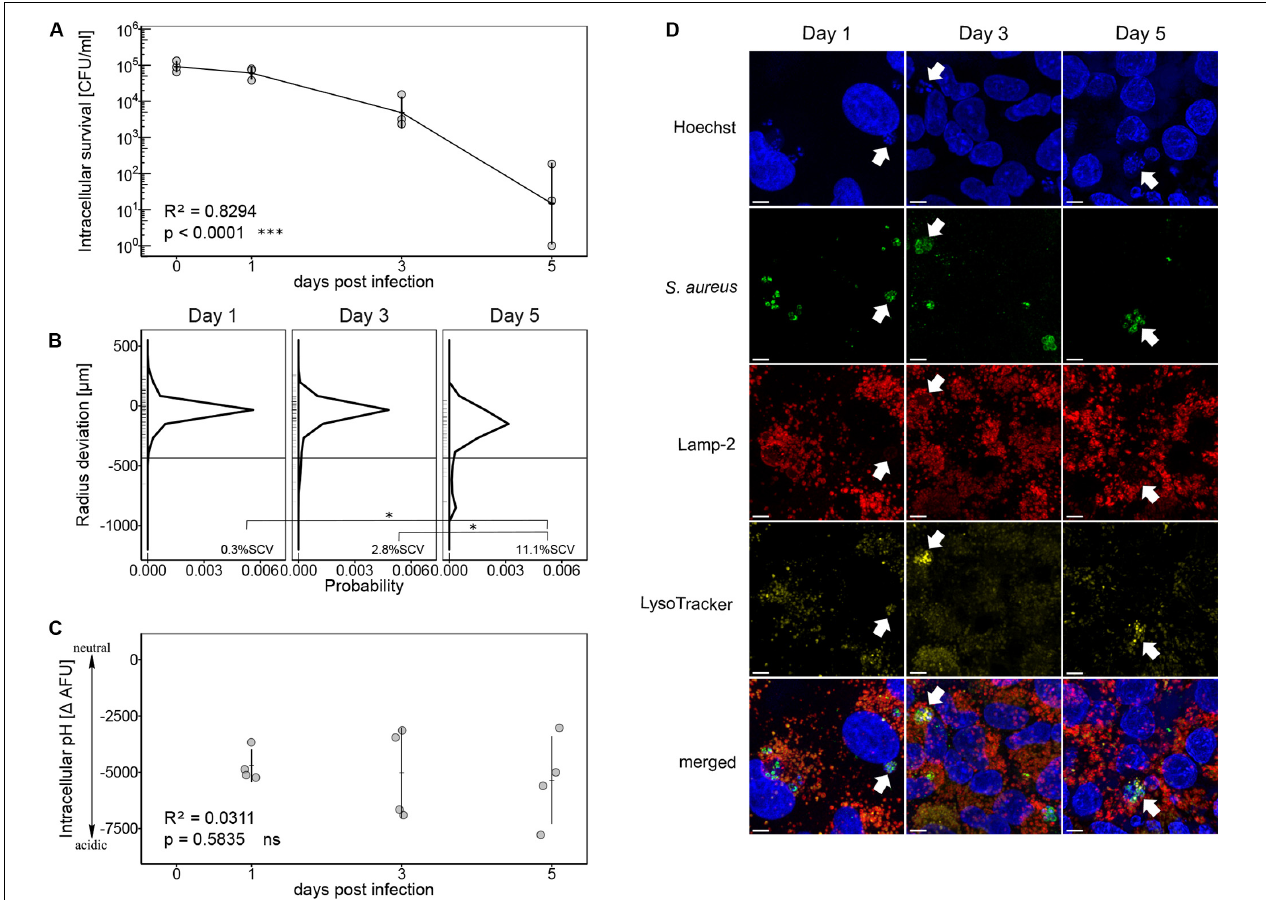
FIGURE 1 | Intracellular survival of S. aureus strain Cowan in acidic endosomes. (A) Recovered bacteria are shown as CFU per ml in log scale over an infection period of 5 days. Three independent experiments in technical triplicates ± SEM are shown. (B) Colony size distribution of recovered bacteria. After 24 h regrowth, colony radius was normalized to the mean colony area at day 0 ( Supplementary Figure 1 ). Radius size deviation from reference is plotted as probability density function. Individual colonies are shown as short lines on y-axis. The threshold for SCVs, indicated as a horizontal line, was calculated as 1/5th of the area of the median area at day 0. The mean percentage of SCVs is written in each panel. Colonies from single images as well as from time-lapse analysis were taken into account. For day one 607 colonies, for day three 362 colonies and for day five 84 colonies were analyzed in two to four biological repeats. Pairwise comparison of day one and day five ∗ p = 0.0172, pairwise comparison of day three and day five ∗ p = 0.0362. (C) Measurement of intracellular pH after 1, 3, and 5 days of infection. Four independent experiments in technical triplicates ± SEM are shown. (D) CLSM of intracellular S. aureus strain Cowan. Co-localization of S. aureus strain Cowan with Lamp-2-positive compartments and LysoTracker signal are indicated by arrows. Length of scale bar is 5 µ